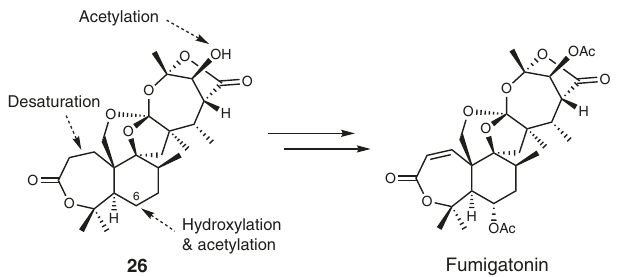
Fig. 5 Biosynthesis of fumigatonin. Structure of fumigatonin and reactions required to synthesize fumigatonin from 26